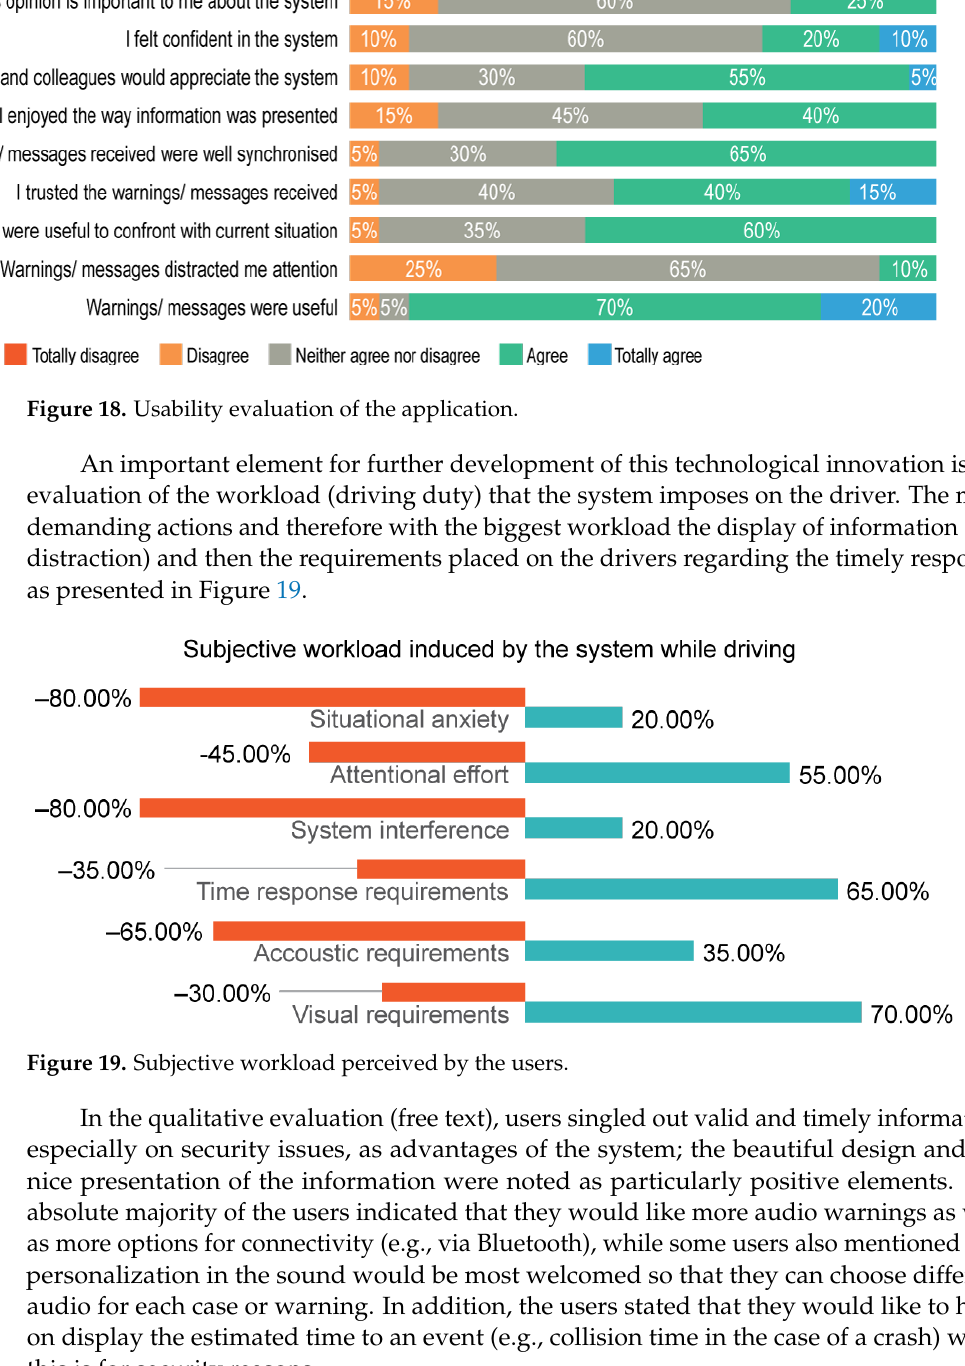
Figure 20. Expected impacts of the system. From the evaluation of the user acceptance from the side of the road operators, the results are very positive for the particular features that strengthen the acceptance of the system. The respective reliability results for the operators show a big confidence of the users as much for the functionality of the system as well as the provided information. Regarding the market penetration, all road operators would consider themselves as future users of the system and like to use it, while the majority (60%) of them intend to pay for this use. The great majority of these (40% with intensity of nine (9) out of ten (10), 40% with ten (10) out of ten (10) and 20% with seven (7) out of ten (10)) would recommend the system to a colleague. Among the advantages of the system, the majority mention the timely and immediate provision of information about the condition of the road coating,